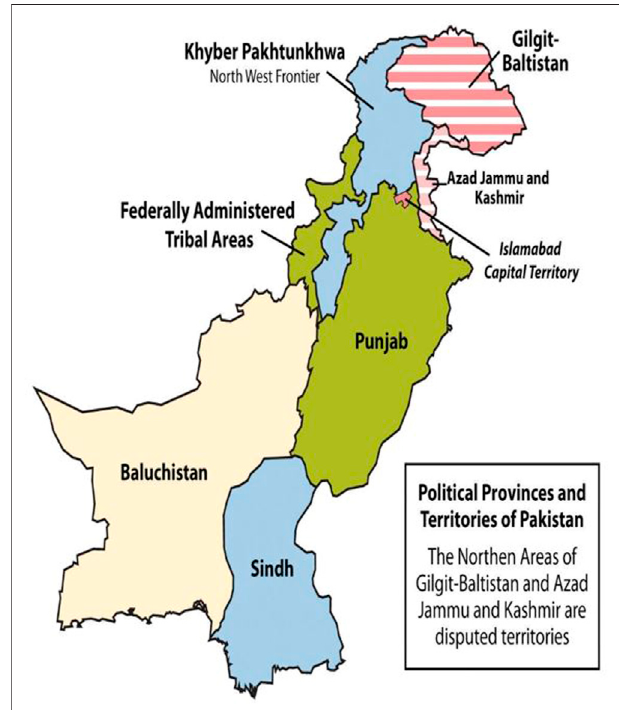
FIGURE 3 | Map of Pakistan and Sindh province; Source: Kalwar, Dali, Hassan, (2018).